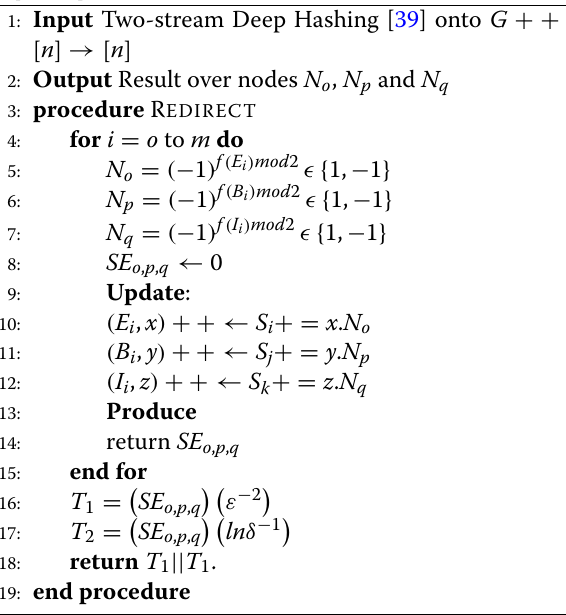
Algorithm 1 Labeling the Sensory Device Stream